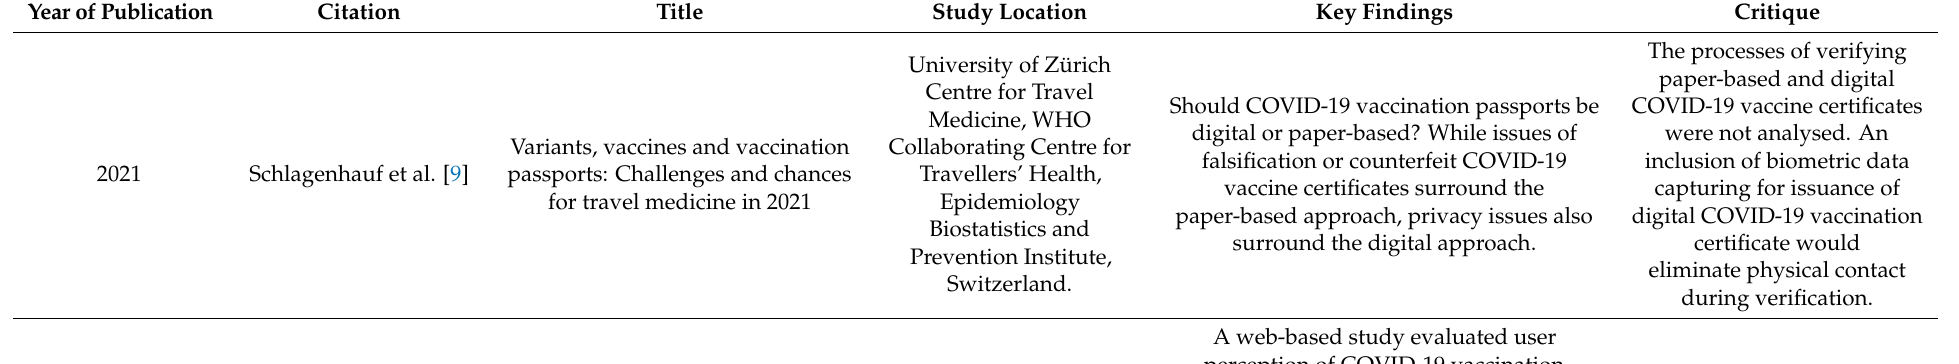
Table 8. Digital and paper-based COVID-19 vaccination certificates: the advantages and